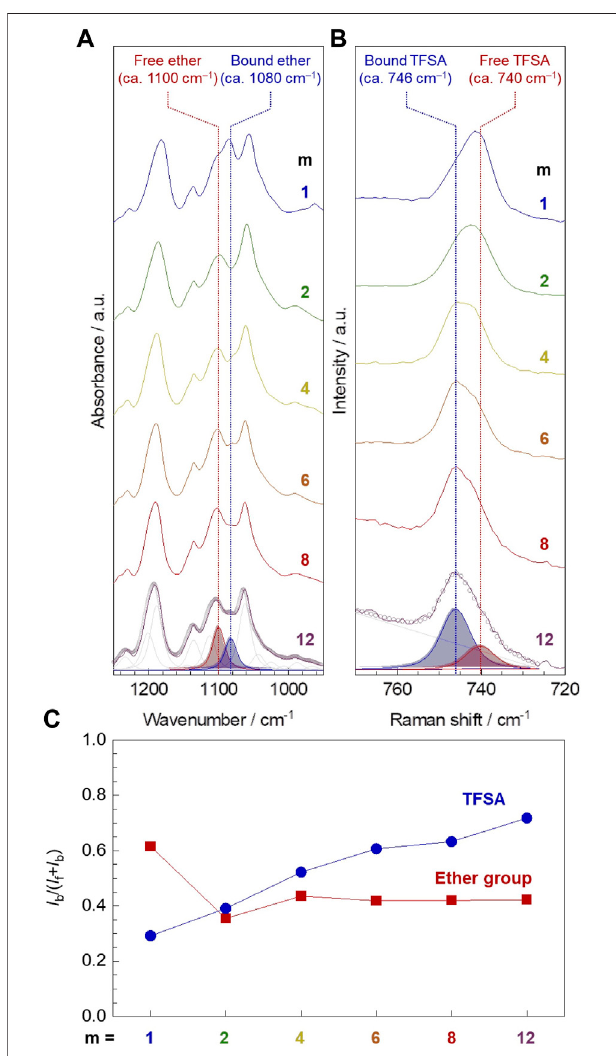
FIGURE 6 | Interaction between Li + and ether group/TFSA anion in PCmEO-LiTFSA. (A) Infrared (IR) spectra of ν as (COC) region and (B) Raman spectra of δ s (CF 3 ) region (solid line). The alkyl side chain becomes longer in order from top to bottom; m = 1, 2, 4, 6, 8, and 12. Peak deconvolution was performed by PeakFit software using pseudo-Voigt functions with a fi xed half-width at half-maximum, and representative deconvoluted peaks are shown for PC12EO-LiTFSA. The open circle shows typical curve- fi tting results. (C) Alkyl side chain length dependency of the ratio of the peak area assignedtopolargroups(redsquare forethergroupsand bluecircleforTFSA anion) interacting with lithium-ion ( I b ) to the total peak area ( I f + I b ).